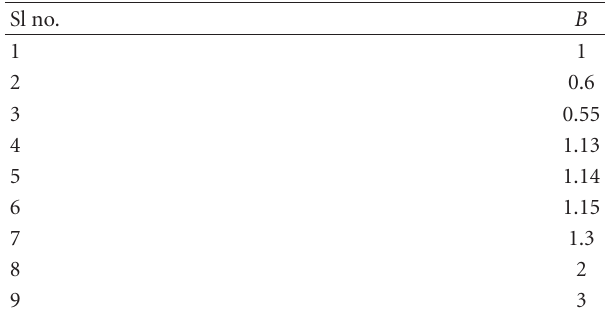
Table 4: Di ff erent B values with respect to B = 1